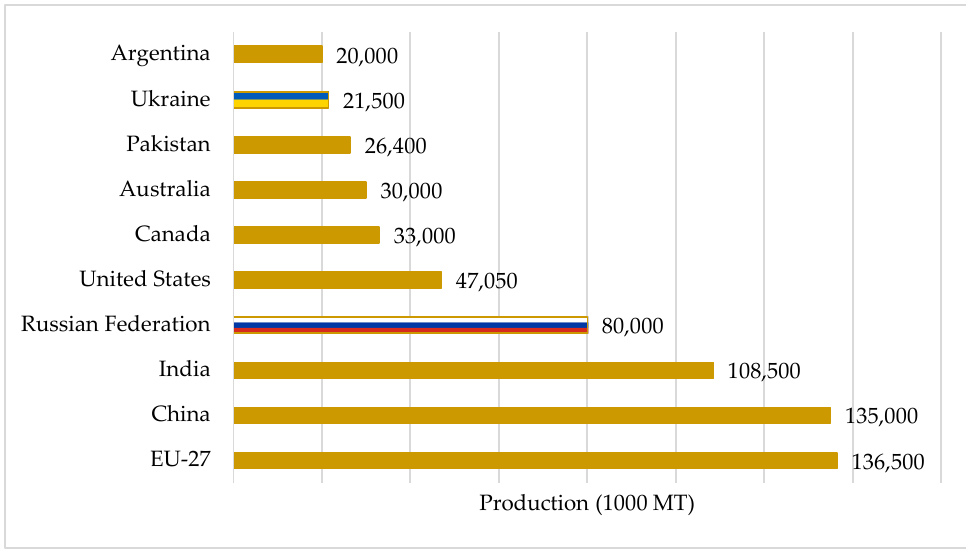
Figure 1. Estimated wheat production in 2022. Source: [25].